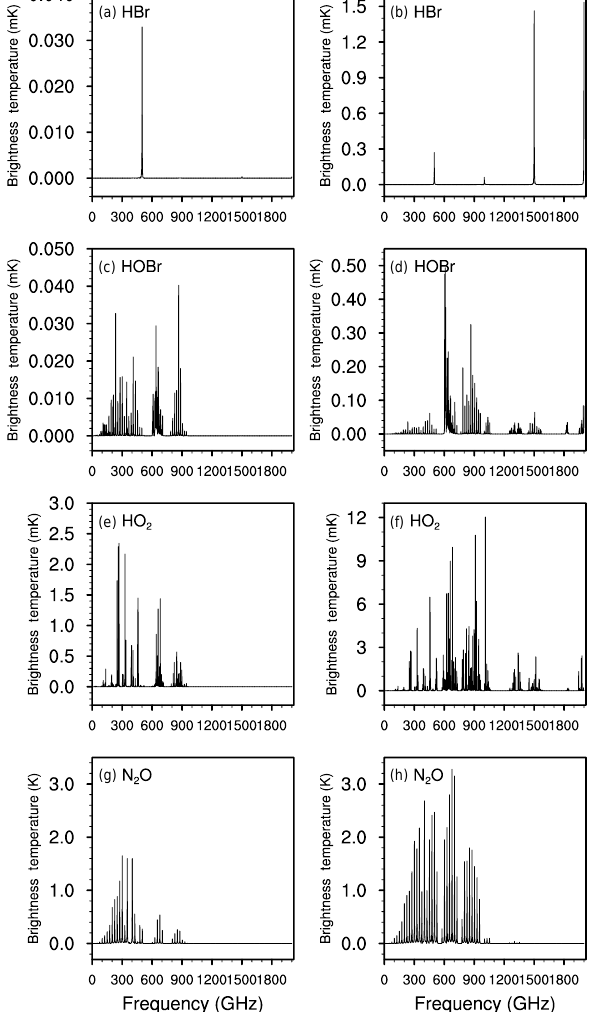
Figure 9. Total frequency range surveys of signal strength for the four species of interest at Summit (zenith angle=0 ◦ ) calculated as residual brightness temperatures between simulations of the com- plete atmosphere with and without the species (0.5GHz sampling resolution). The plots on the left-hand side ( a , c , e and g ) are for the annual mean scenario and those on the right-hand side ( b , d , f and h ) are for the < 10% PWV scenario. Units of the ordinate scale are milliKelvin (mK) except for the N 2 O plots which are in K. Note the different ordinate scales for each